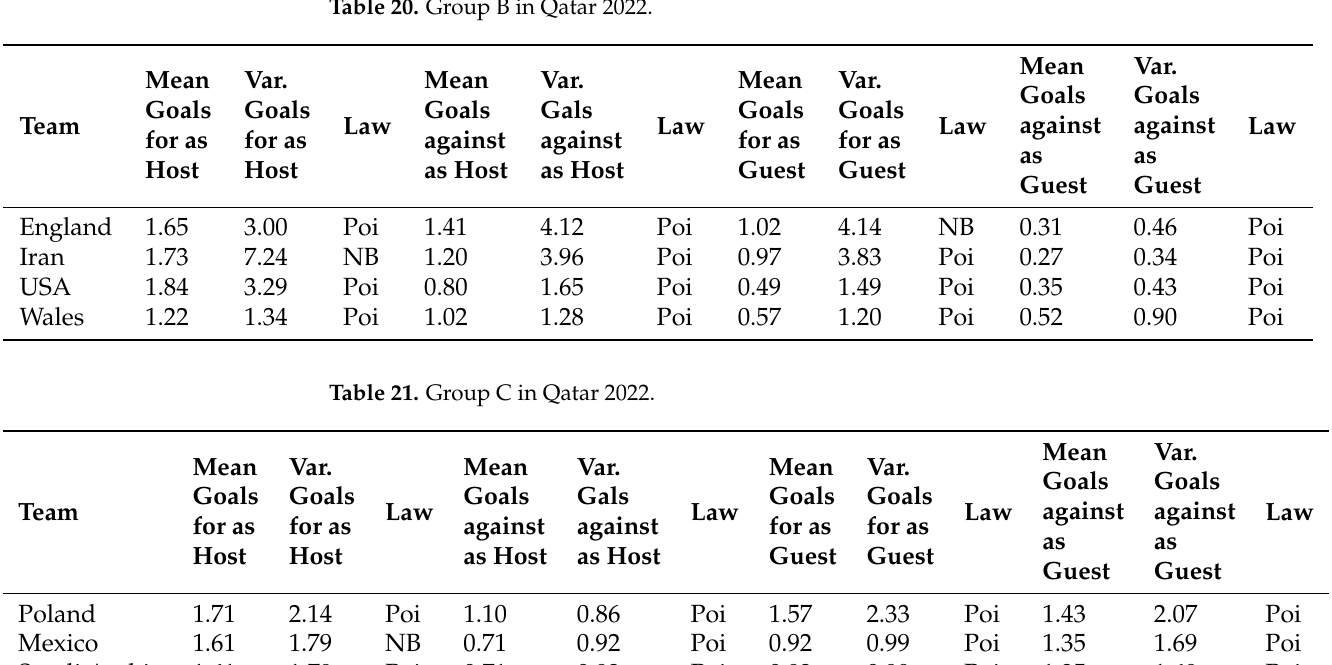
Table 20. Group B in Qatar 2022.